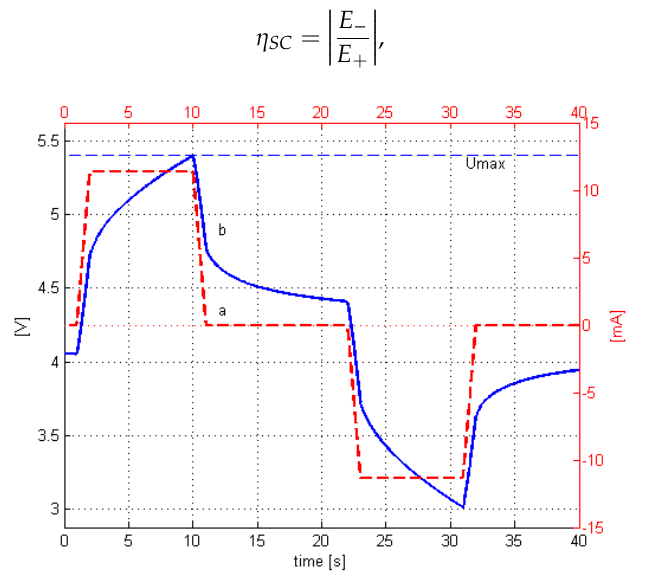
Energies 2020 , 13 , x FOR PEER REVIEW Figure15. Thecurrent( a )andvoltage( b )waveformsofSCof0.47Fcapacityand5.4Vmaximumvoltage. Figure 15. The current ( a ) and voltage ( b ) waveforms of SC of 0.47 F capacity and 5.4 V maximum voltage.